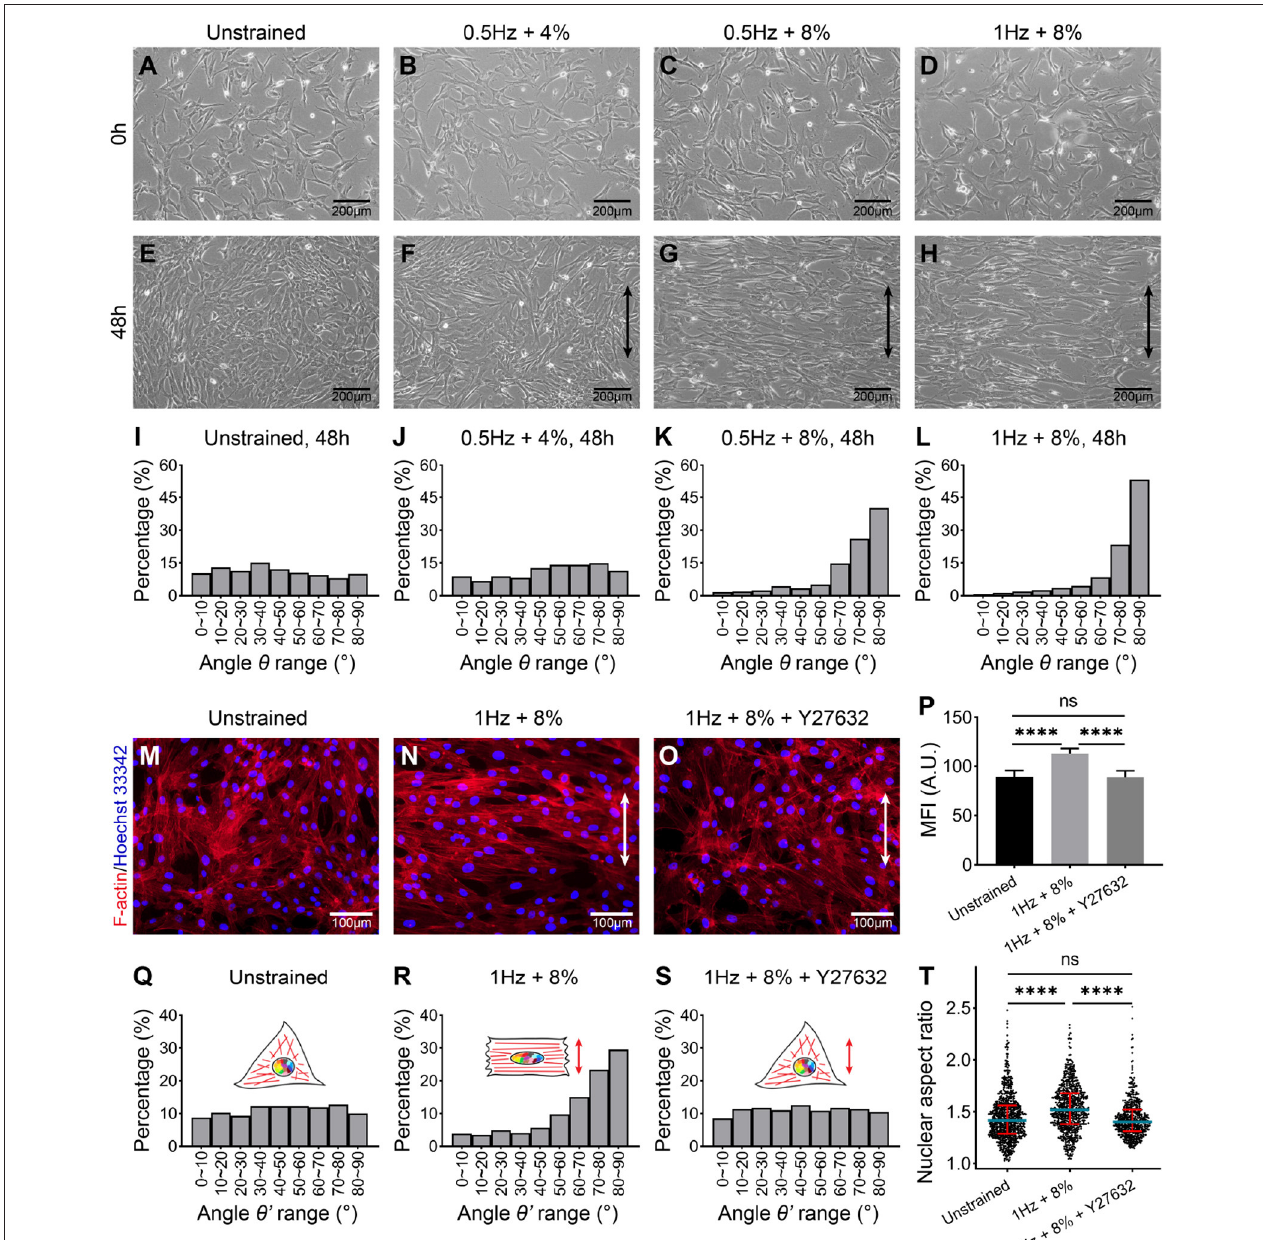
FIGURE 2 | Phase-contrast images of hMSCs cultured on polydimethylsiloxane (PDMS) for 24 h before uniaxial cyclic stretching (UCS) (A–D) and subjected to UCS at different amplitude and frequency for 48 h (E–H) . Black double-headed arrows indicate the direction of stretching. (I–L) Distribution analysis of angle θ between the direction of cell spread (shown in E–H ) and cyclic stretch. Every 10 ◦ is a range. Numbers of hMSCs measured orientation angle in each group (I–L) were 484, 434, 413, and 304, respectively. The cells from four biological replicates were counted together. (M–O) Representative fluorescence images of F-actin (red) and nuclei (blue) staining of hMSCs under unstrained and cyclic stretch for 48 h. The hMSCs in (O) were treated with ROCK inhibitor, Y27632, before cyclic stretch. The direction of UCS was in the white double-headed arrow direction. (P) Mean fluorescence intensity (MFI) of F-actin in (M–O) . Significant differences were noted by **** P < 0.0001. ns signifies P > 0.05. n = 4. (Q–S) Distribution analysis of the angle between the direction of nuclear long axis and UCS. The angle is represented by θ ’. Every 10 ◦ is a range. Numbers of nuclei measured orientation angle in each group were 739, 686, and 520, respectively. The nuclei from four biological replicates were counted together. (T) Population distribution of hMSCs nuclear aspect ratio (NAR) in unstrained, 1 Hz + 8% and 1 Hz + 8% + Y27632 condition for 48 h. Blue lines indicate the median of data set, and red lines indicate quartiles. Numbers of nuclei measured NAR in each group were same as in (Q–S) . Significant differences were noted by **** P < 0.0001. ns signifies P >